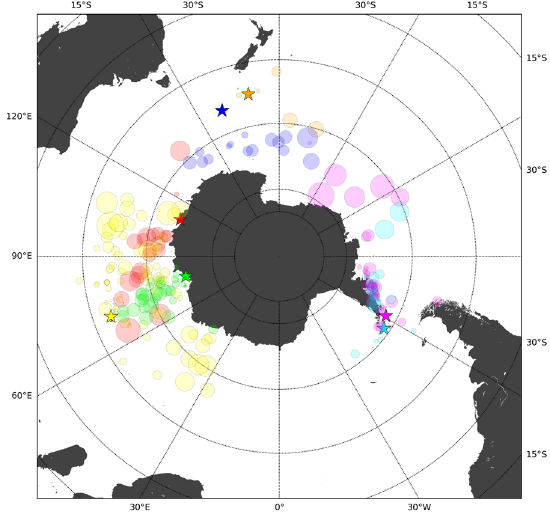
Figure 3. Spatial extent of the trajectories. Map of the position of the centre of mass of each trajectory. Symbol size is proportional to the gyration radius r G ; colours indicate different deployment locations (associated with different populations) which are represented with star symbols: Kerguelen (yellow), Macquarie (blue), Campbell (orange), Livingston (magenta) and Elephant (cyan) Islands, Casey (red) and Davis (green) Stations. Map generated with Matplotlib Basemap Toolkit 55 .